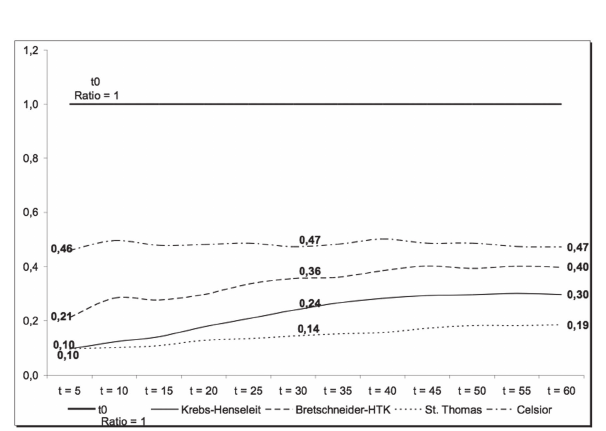
Fig. 3 - Maximum rate of rise in left ventricular pressure (+dP/dt), according to the solution. Reperfused hearts were monitored for 60 min with the following solutions: Krebs-Henseleit Buffer, Bretschneider-HTK, St. Thomas No. 1, and Celsior. Baseline was calculated after stabilization and prior to